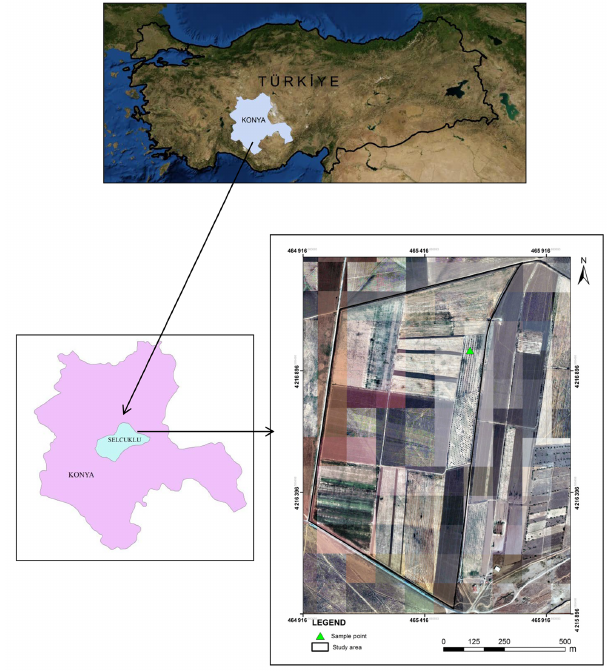
Figure 1. Geographical location of the experiment station of the Agricultural Faculty at Selçuk